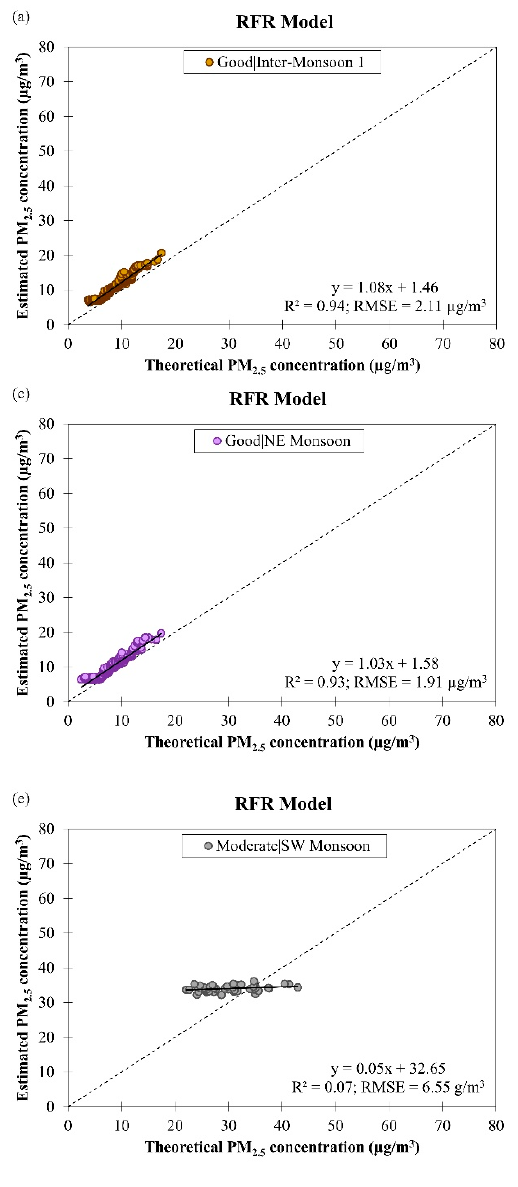
Figure 15. Scatter plots of estimated daily PM 2.5 concentration against theoretical daily PM 2.5